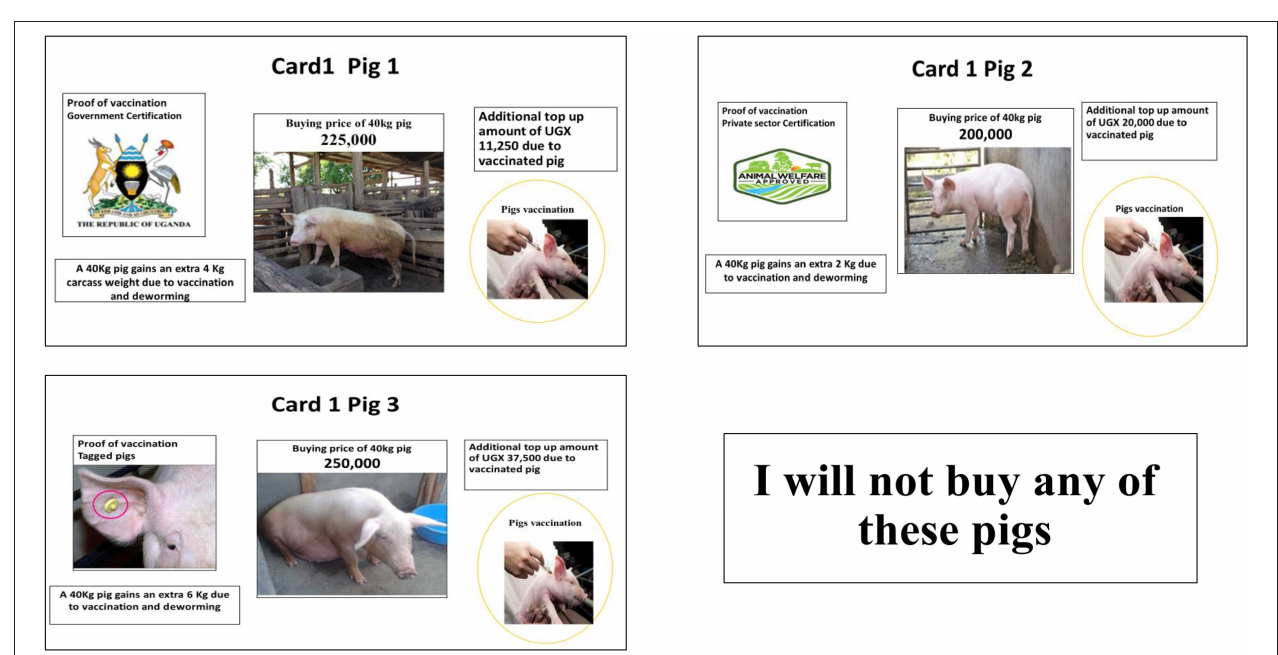
FIGURE 2 | An example of a choice set option for traders.